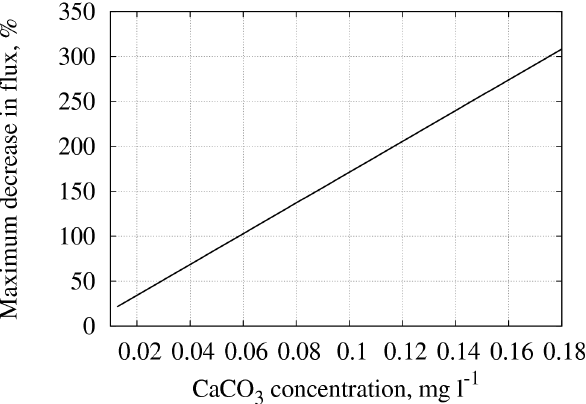
Fig. 5. Sensitivity of the maximum percentage reduction in air-sea flux of CO 2 (across all years, months and regions) to concentra- tion of CaCO 3 -C (inmgl − 1 ) . Figures 3 and 4 are calculated for a CaCO 3 -C concentration of 0.075mgl − 1